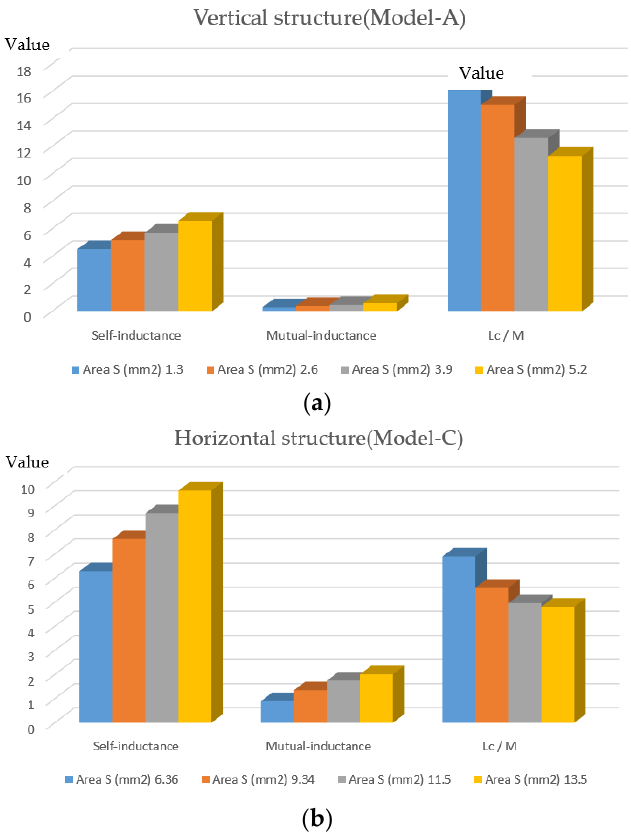
Figure 6. FEM results under magnetic flux incident in different areas: ( a ) vertical structure coil model and ( b ) horizontal structure coil model. Table 2. Influence of the inductance under different magnetic flux incident areas S with the FEA method. Coil Type